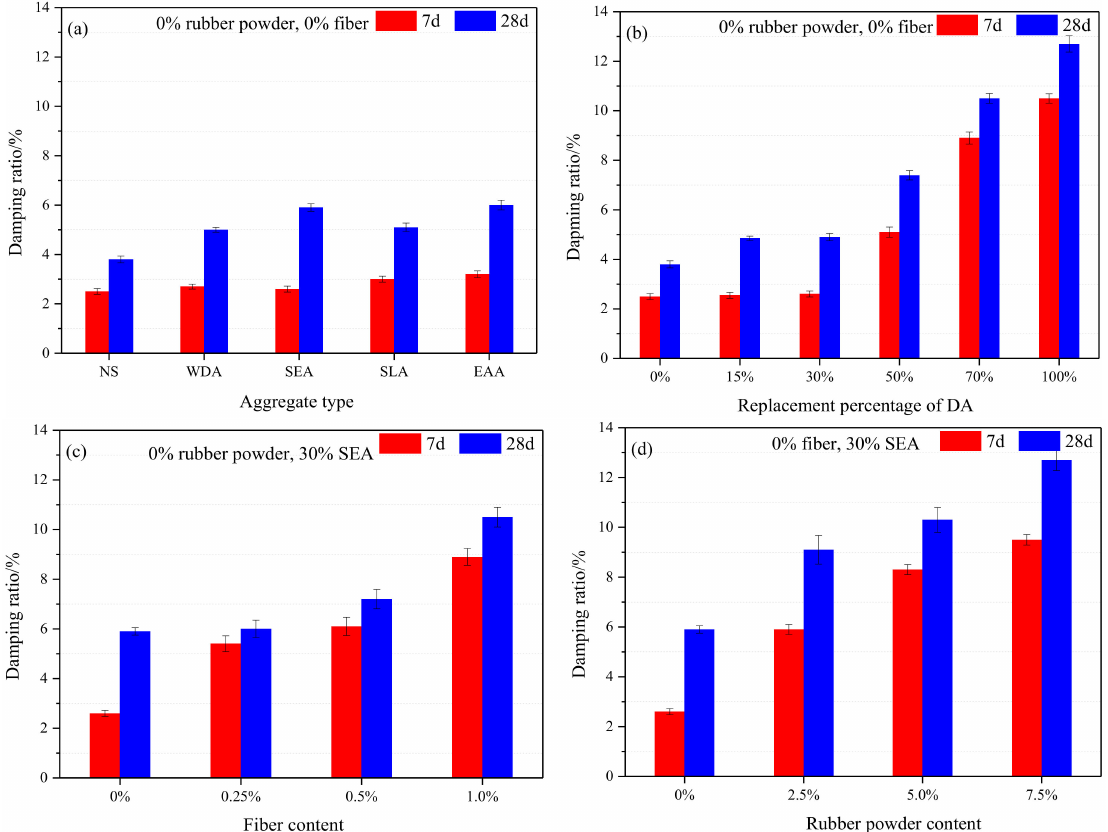
Figure 9. Damping ratio of the cement mortar: ( a ) aggregate type; ( b ) replacement percentage of DA; ( c ) fiber content, and ( d ) rubber powder content.